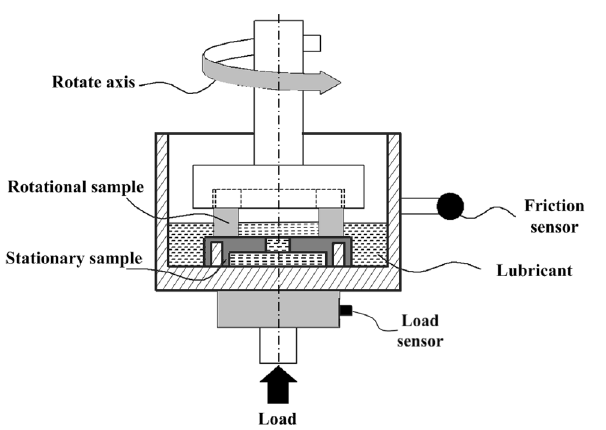
Figure 4. Schematic of test